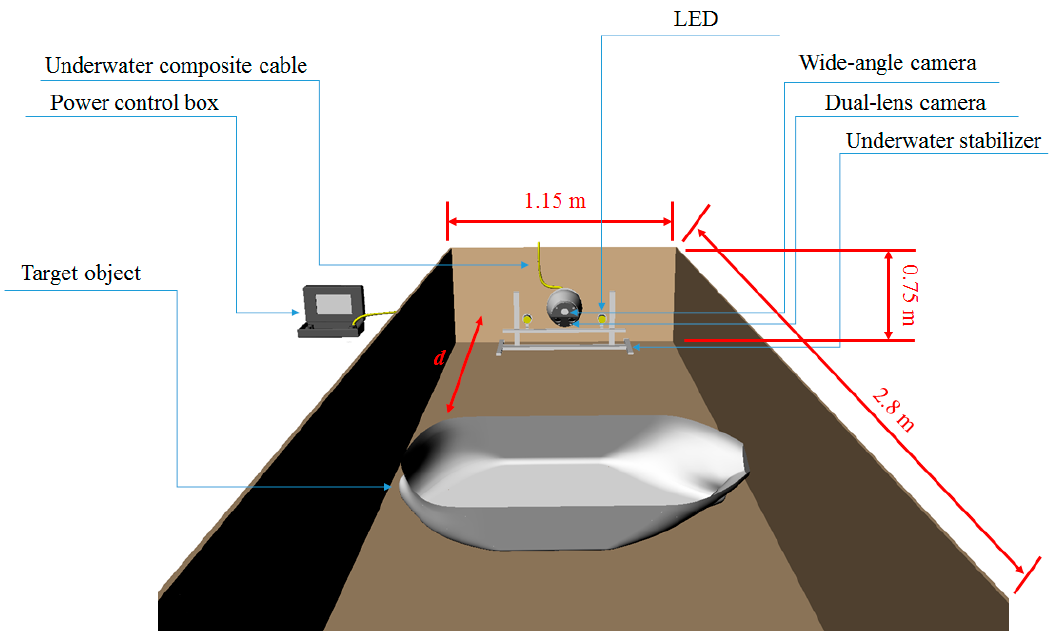
Figure 13. The experimental set-up and facilities in the stability water tank at Department of Systems and Naval Mechatronic Engineering, NCKU. Table 6. Specification table for underwater composite cables.